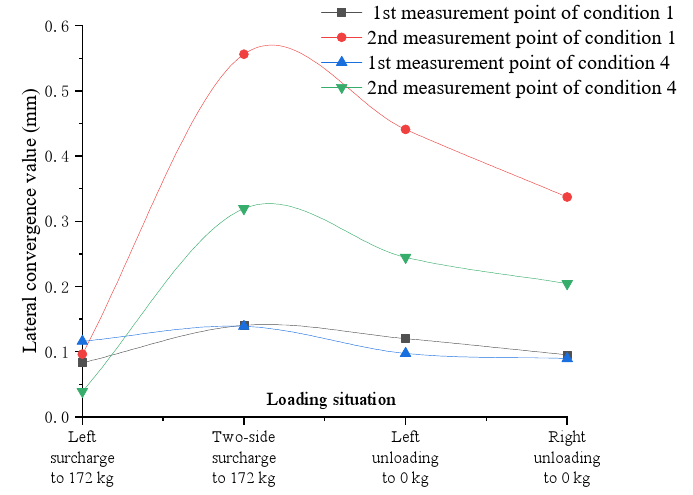
Figure 18. Variation of transverse convergence with surcharge for the 1st and 2nd measurement points in Case 2 and Case 4. Analysis of Figures 16–18 shows the following: (1) In the wet sand, the maximum transverse convergence value of the tunnel occurs at measurement point 2 when the eccentric surcharge on two sides of the tunnel is 172 kg, which is consistent with the case of dry sand in soil under the same conditions, but the maximum transverse convergence value of the tunnel in the wet sand is 0.3193 mm—only 57.4% of the transverse convergence of the tunnel in the dry sand under the same conditions—indicating that under the same test conditions, com-